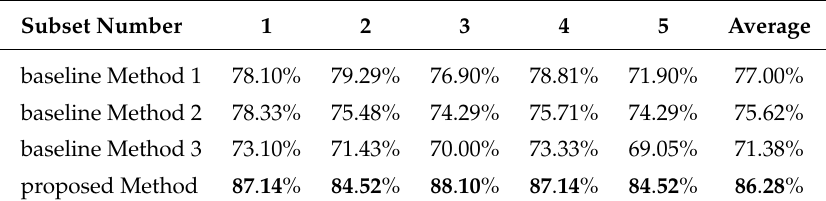
Table 1. classification accuracies over all five groups of our